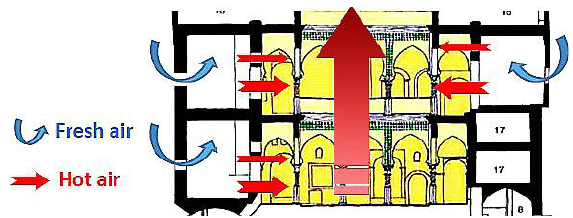
Figure 12. Chimney effect and transversal ventilation in a house of the Kasbah of Algiers (Benchekroun, 2019 treated by the